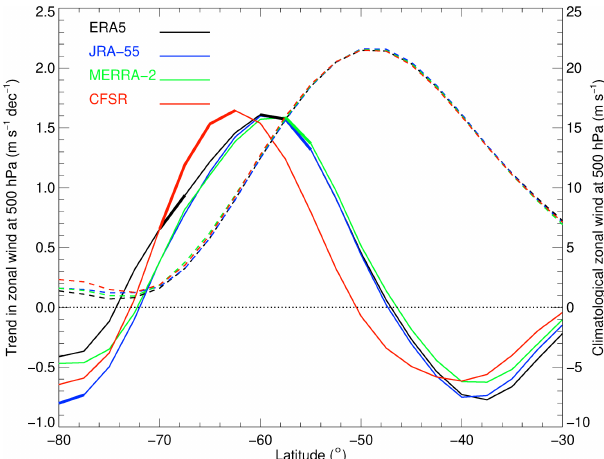
Figure 3. DJF trend and mean in zonally averaged 500hPa zonal wind from 1980 to 2001 for ERA5 (black line), JRA-55 (blue line), MERRA-2 (green line), and CFSR (red line). The trend is indicated by the solid lines (left y axis; units: ms − 1 per decade) and the cli- matological mean by the dashed lines (right y axis; units: ms − 1 ). Thick solid lines denote latitudes where the trends are significant at the 5% significance level. Note that the right and left axes have different